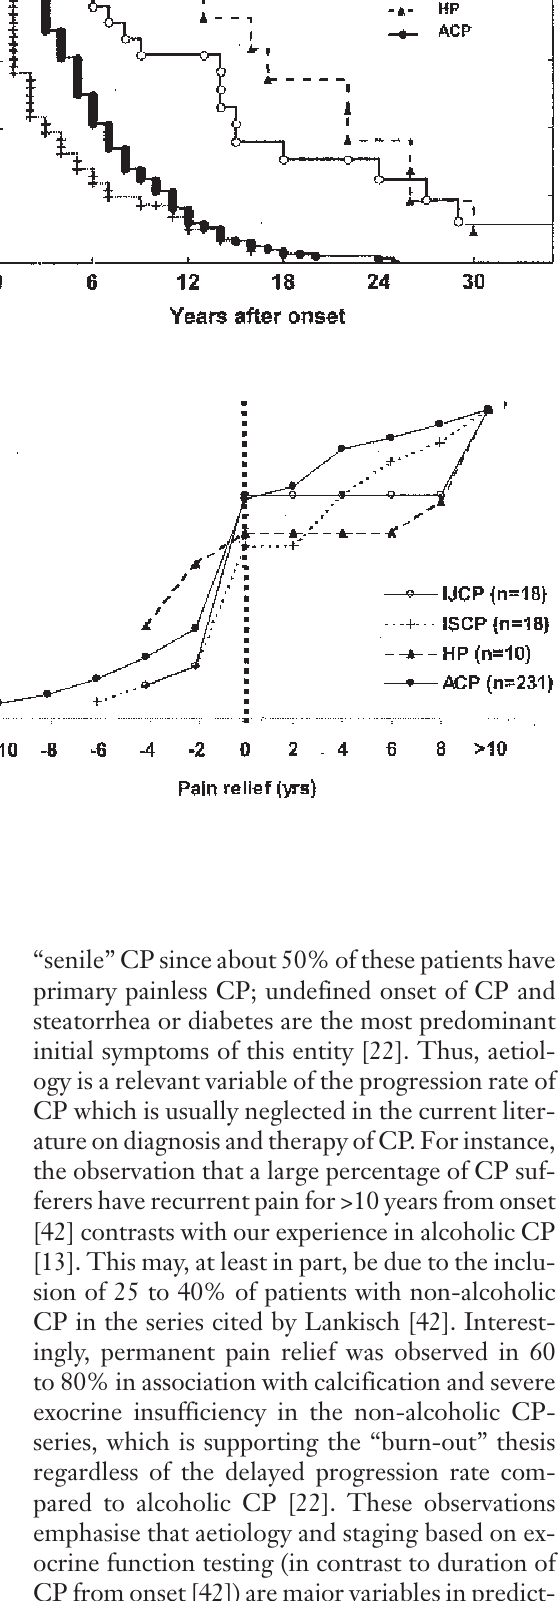
Figure 4 Probability of no exocrine insufficiency in relation to years from disease onset of chronic pancreatitis of different aetiology (Kaplan-Meier). The progression to exocrine insufficiency was significantly delayed in hereditary (HP, n = 11) and idiopathic “juvenile” (IJCP, n = 26) compared to alcoholic (ACP, n = 265) and idiopathic “senile” (ISCP, n = 46) chronic pancreatitis (see ref.